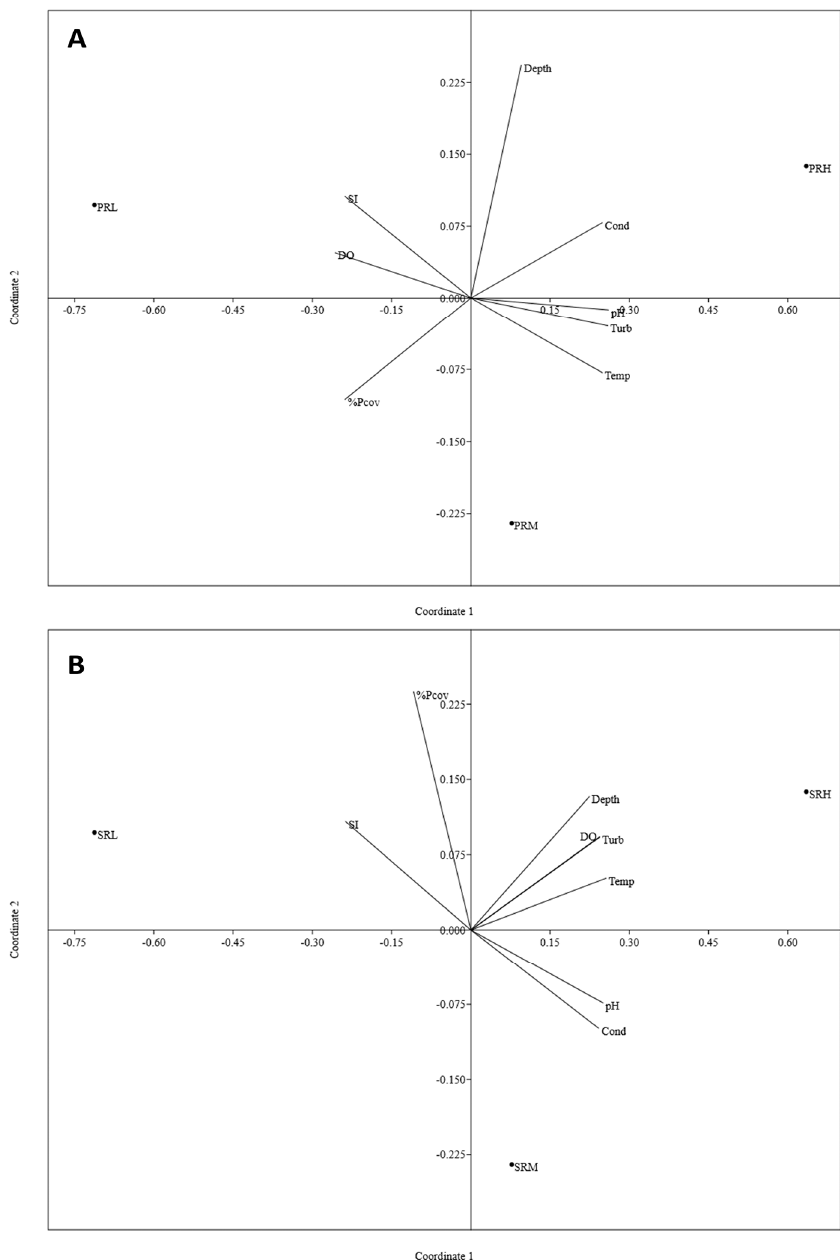
Figure 4. Non-metric multidimensional scaling (NMDS) results from the ordination of Xiphocaris elongata densities. Stream habitat variables were measured at the different sampling sites in ( A ) urban watershed (R í o Piedras) (PRH-Piedras River high urban reach, PRM-Piedras River medium urban reach, and PRL-Piedras River low urban reach) and ( B ) forested watershed (Rio Sabana)(SRHSabana reach) were plotted as vectors. Vector length and direction reflect the strength and direction of the relationship between the stream habitat variables (Depth-pool depth, SI-substrate index, Pcov-%pool cover, DO-dissolved oxygen, Cond-conductivity, Temp-temperature, Turb-turbidity) and Xiphocaris elongata